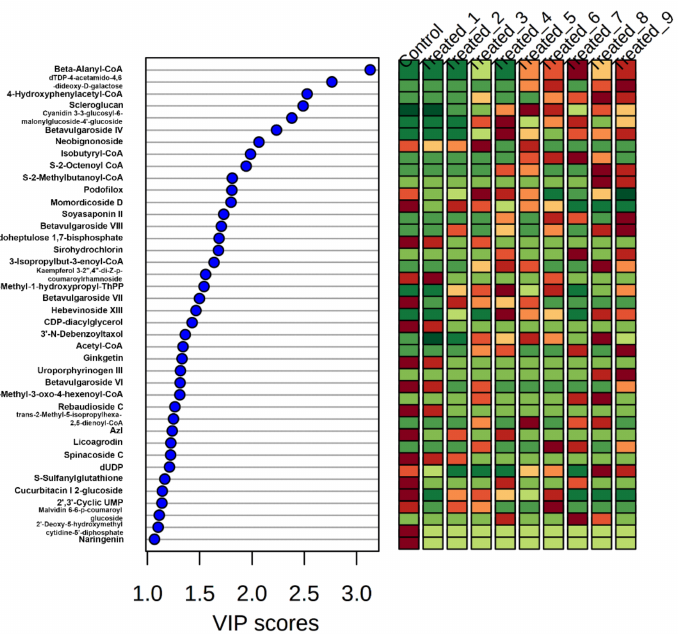
Figure 13. VIP scores of significantly expressed metabolites were identified with PLS-DA analysis, which was adopted for pathway